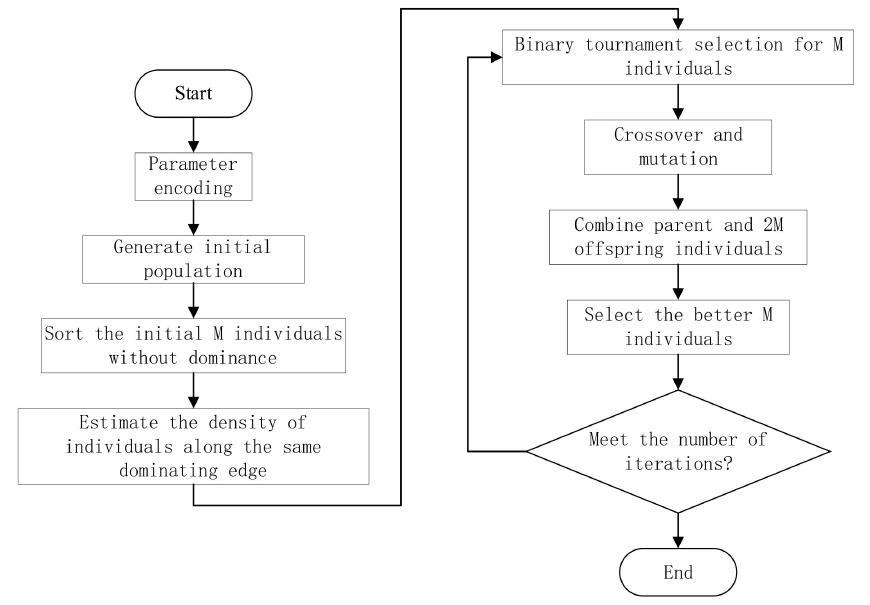
Figure 8. Multi-objective genetic algorithm